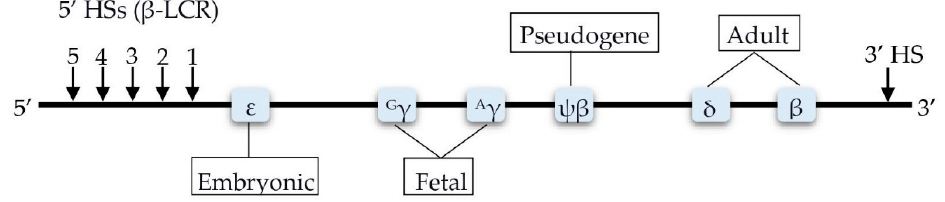
Figure 2. Schematic of β –globin cluster. HS, hypersensitive sites; LCR, locus control